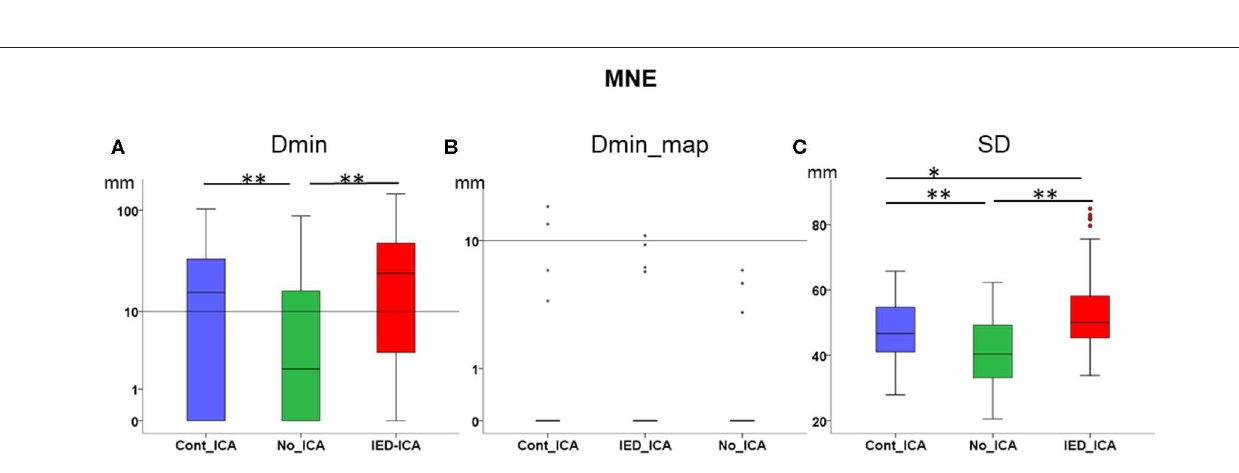
FIGURE 3 | Effect of ICA on MNE. (A) Dmin was significantly lower (better) for No_ICA as compared to Cont_ICA and IED_ICA. (B) Dmin_map did not differ across approaches, probably due to a floor effect. (C) The spatial dispersion was significantly higher (worse) for both Cont_ICA and IED_ICA as compared with No_ICA. SD was also higher for IED_ICA as compared to Cont_ICA. * p < 0.05; ** p <